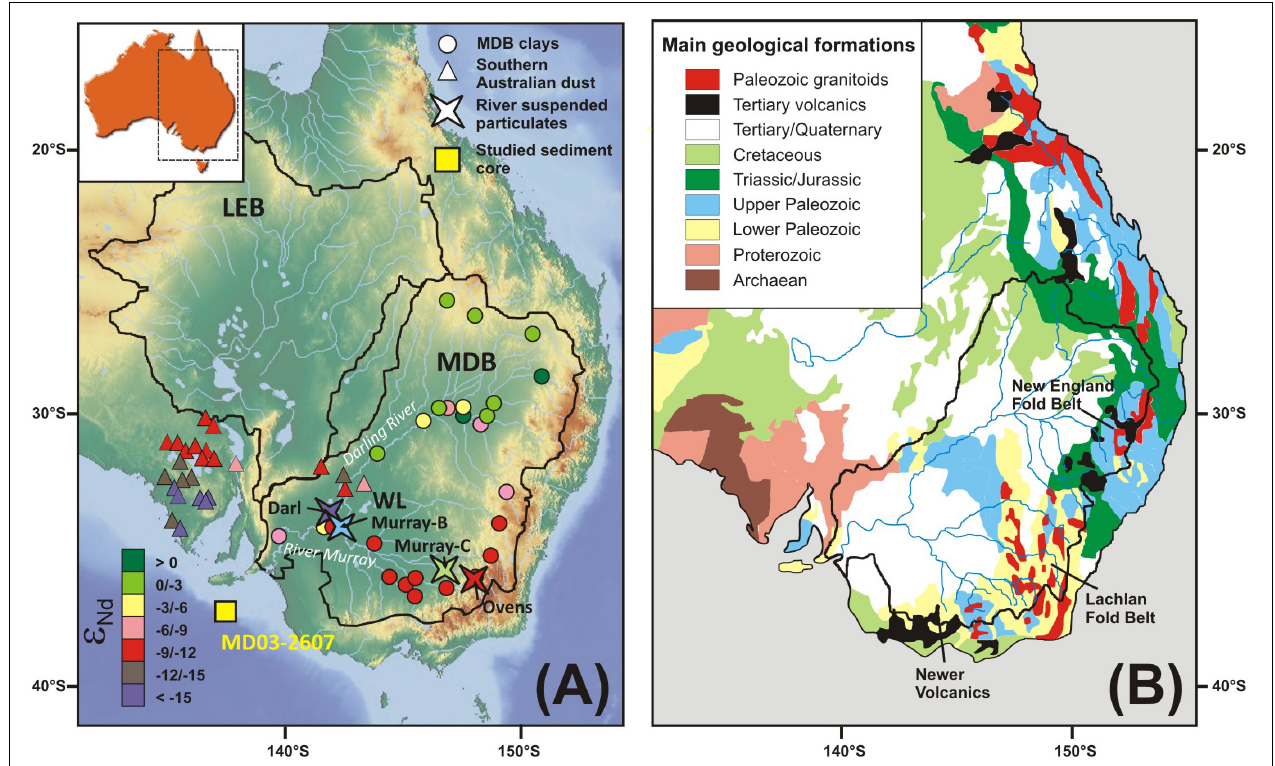
FIGURE 1 | (A) Location of studied river particulate samples in the Murray-Darling Basin (MDB) and marine sediment core MD03-2607. The range of neodymium isotopic compositions ( ε Nd ) for MDB suspended particulates (stars) and clay-size fractions (Gingele and De Deckker, 2005a; circles), and southern Australian dust sources (De Deckker et al., 2014; De Deckker, 2019; triangles) are also represented. LEB refers to Lake Eyre Basin. (B) Simplified geological map of Southeast Australia (redrawn from Palfreyman et al., 1976).